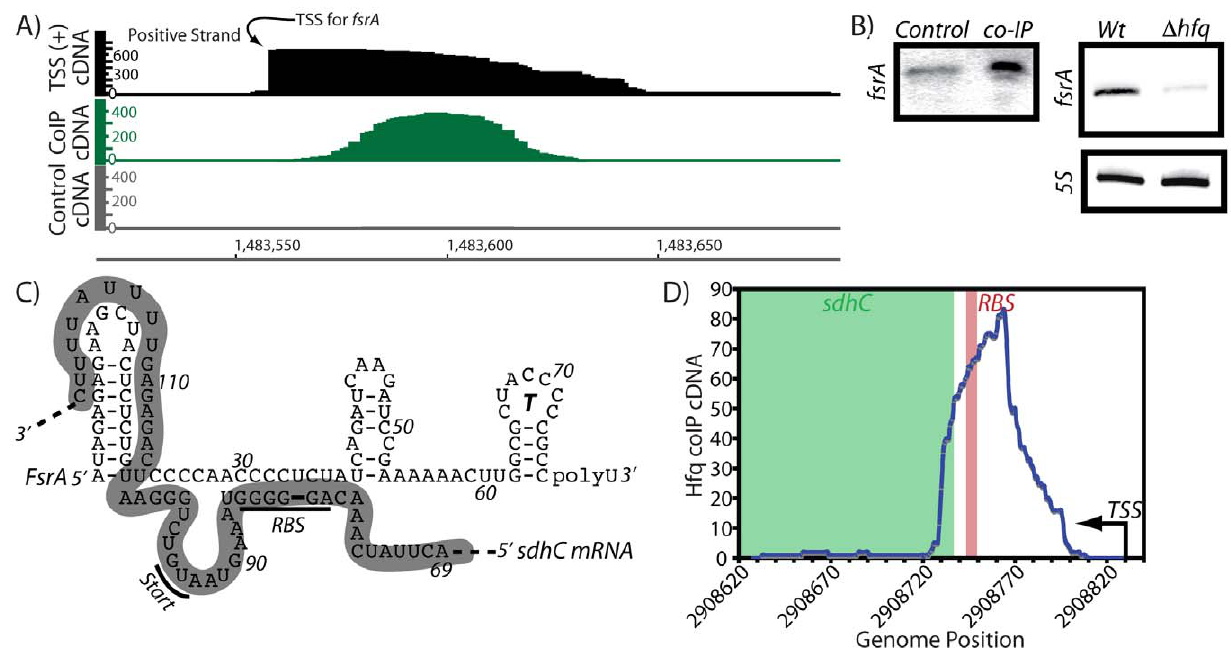
Figure 7. Hfq associates with the iron homeostasis sRNA regulator, FsrA. Previously, an sRNA regulator (FsrA) was identified as an important regulator of iron homeostasis genes [29]. The transcription start site of fsrA was identified previously [29,33] and is shown in panel (A). In this study, Hfq is shown to coIP with the FsrA sRNA. In this panel, the y-axis shows the volume of cDNA reads as a function of genomic position (x-axis) as determined by Illumina-based sequencing of Hfq-associated RNA molecules. Data shown in gray correspond to the negative control reaction (coimmunoprecipitation of Hfq that lacked an epitope tag). Data shown in black correspond to a prior transcription start site (TSS) mapping study [33]. (B) Deletion of hfq resulted in moderately lowered abundance of FsrA, as ascertained by northern blotting analysis. (C) A well-characterized mRNA target of the FsrA sRNA is the ribosome binding site region of sdhC [29]. The predicted sRNA:mRNA pairing region is shown herein. The sdhC leader region is indicated in this figure by gray shading. (D) The region of the sdhC transcript that is predicted to pair with FsrA also appeared to coIP with Hfq in this study. The sdhC transcription start site is indicated with an arrow. The ribosome binding site is denoted by a red box and the sdhC coding region is shown in green. One speculative explanation for these data is that Hfq might assist FsrA: sdhC intermolecular interactions, although other explanations are still possible.